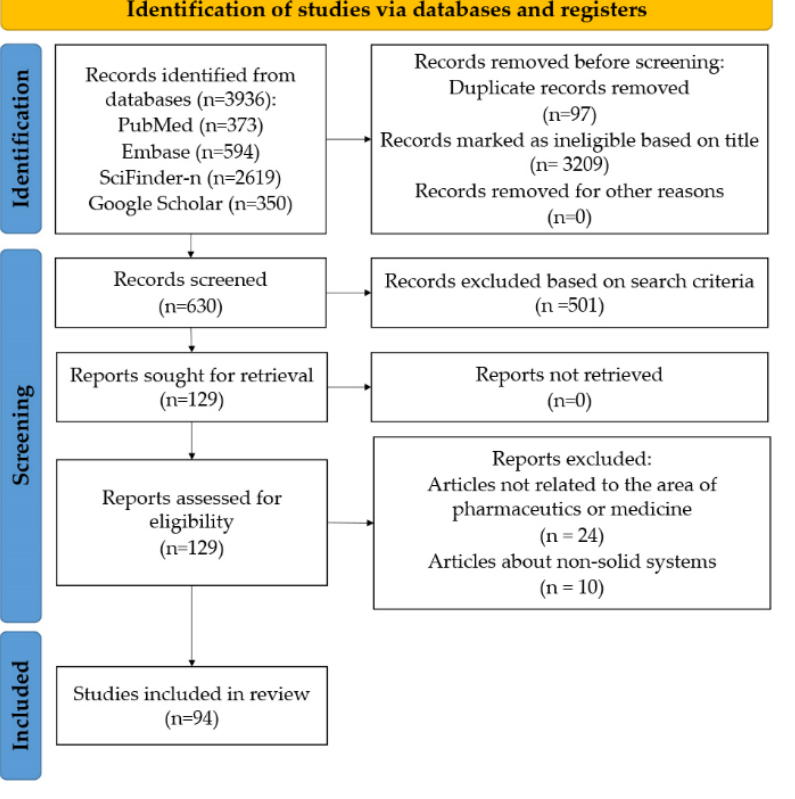
Figure 2. Steps of the selection and screening of the scientific publications according to the PRISMA 2020 flow diagram.